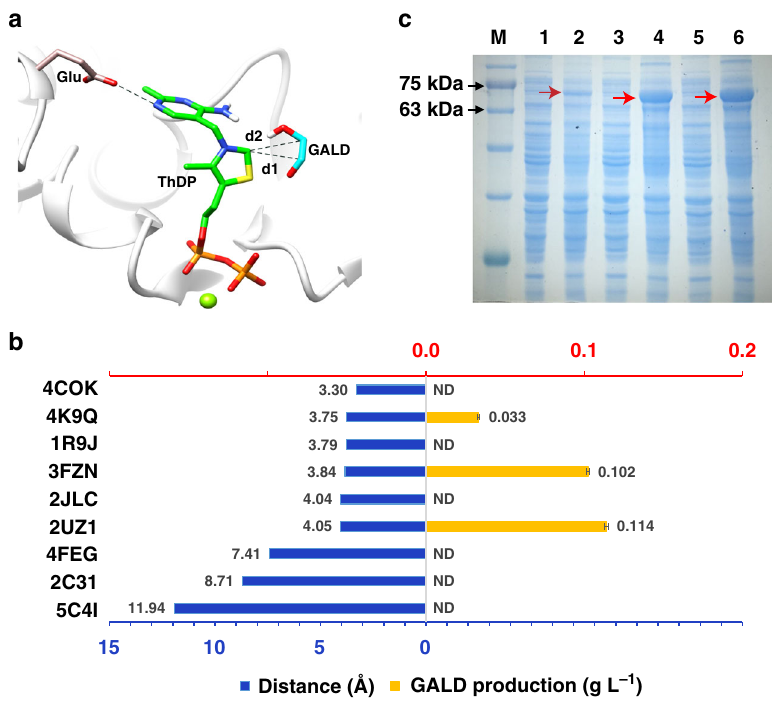
Fig. 2 Theozyme model construction and functional identi fi cation of the glycolaldehyde synthase. a The theozyme model interaction between glycolaldehyde and the active centers of different ThDP-dependent enzymes. The glutamate (glu) is tan; glycolaldehyde is cyan; ThDP is green. The distances between C2 atom in ThDP and glycolaldehyde carbon atoms are represented by d1 and d2. The green dot is magnesium ion. b The average distances (blue) between d1 and d2 in each protein are shown on the left. The amount of product (yellow) for the tested protein are shown on the right. The reaction was carried out by adding 1 mg mL − 1 of the tested proteins and 2 g L − 1 formaldehyde. ND no detection. Error bars represent s.d. (standard deviation), n = 3. c Protein expression of three functional candidates by using 1 mL of 1 OD cells. M: protein marker; 1, 3 and 5 represent protein expression without IPTG for 2UZ1, 3FZN, and 4K9Q, respectively; 2, 4, and 6 represent protein expression under IPTG inducing for 2UZ1, 3FZN, and 4K9Q, respectively; The red arrows point to the protein bands for 2UZ1, 3FZN, and 4K9Q, respectively. Source data are provided as a Source Data fi mol − 1 (Fig. 1b and Supplementary Table 1). The value of MDF